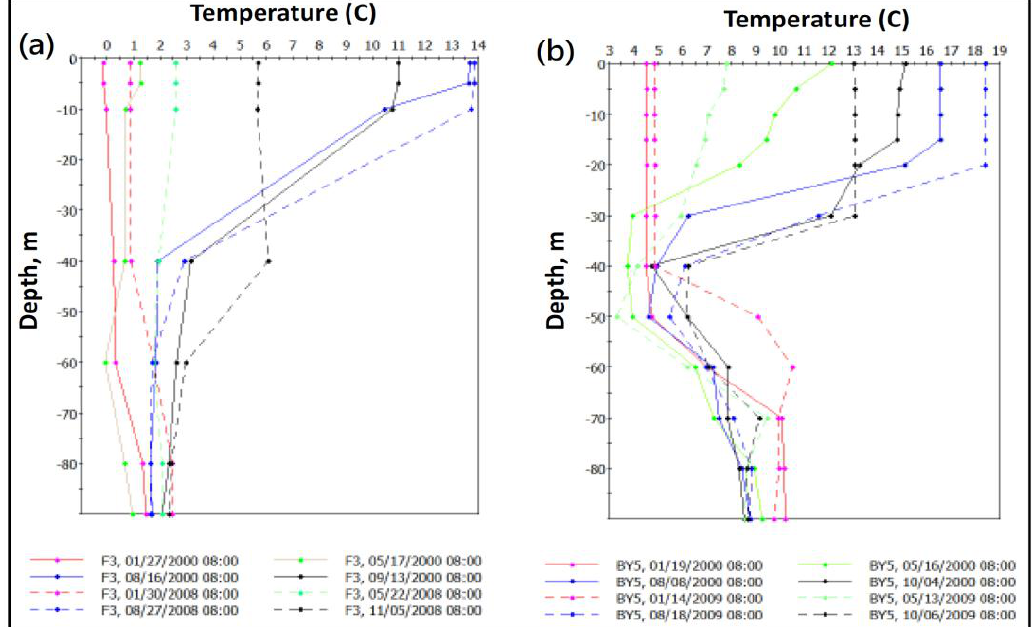
Figure 19. ( a ) Measured temperature profiles at F3 in 2000, 2008 and 2009; ( b ) Measured temperature profiles at BY5 in 2000, 2008 and